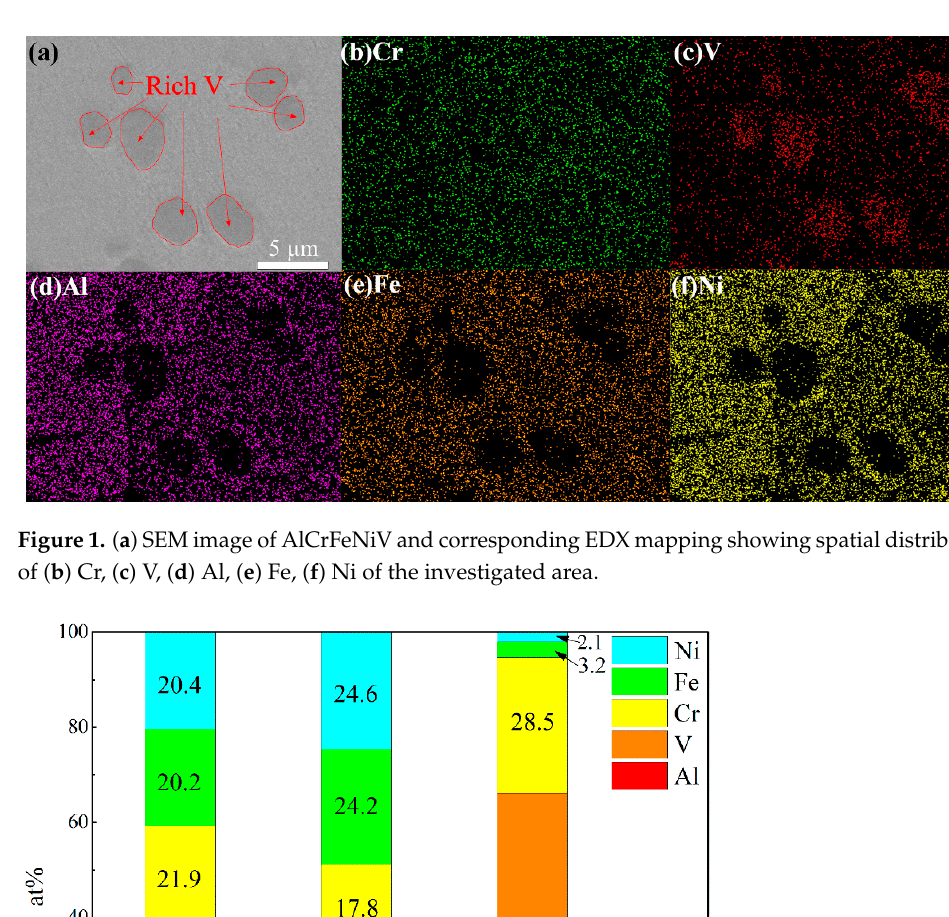
Figure 3. XRD patterns of the AlCrFeNiV block and powders with different ball milling times. Figure 4a shows the TEM image of AlCrFeNiV high-entropy alloy, and Figure 4b,c show the corresponding electron diffraction patterns. Figure 4b,c show that the AlCrFeNiV alloy is not just a single body-centered cubic (BCC), but a mixture of two BCC structures with different lattice constants. It can be seen from the XRD patterns that the powder evolution process of BCC2 is dominated by V element. Moreover, in Figure 4c, there are very few twins in the electron diffraction.